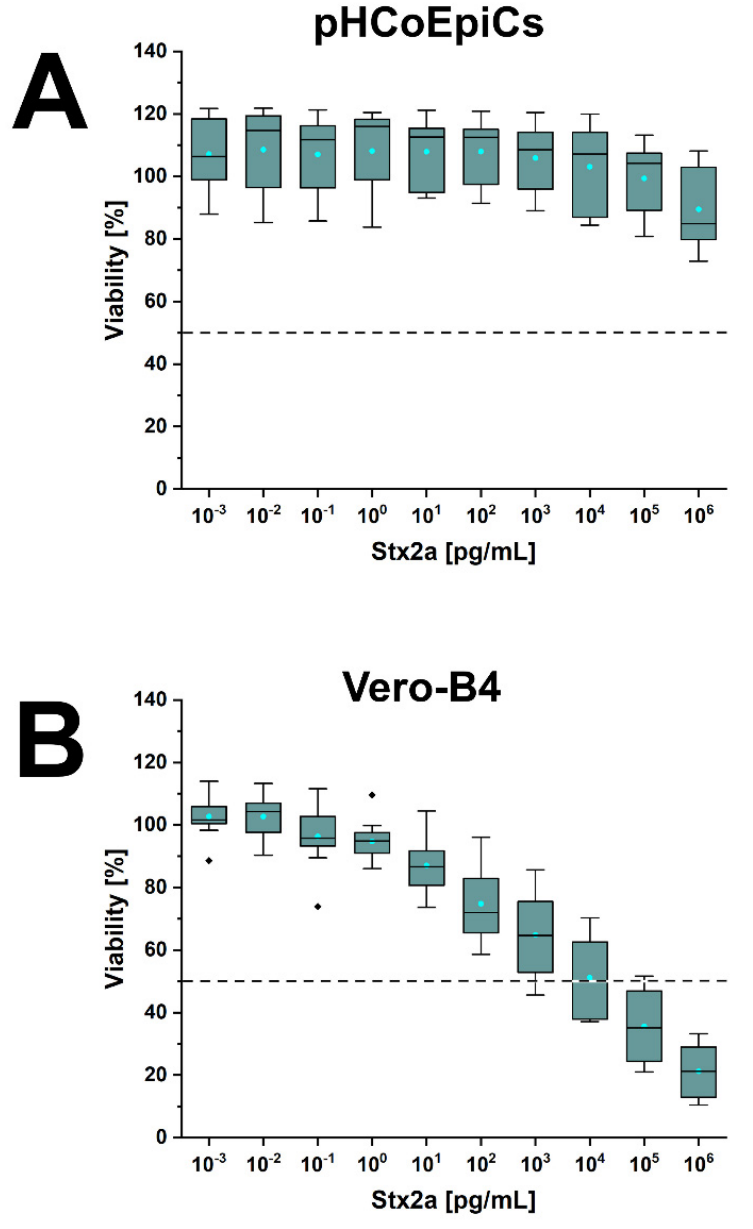
Figure 11. Cytotoxic effect of Stx2a towards pHCoEpiCs ( A ) and Vero-B4 reference cells ( B ). The cell-damaging activity was analyzed with the crystal violet assay, and absorption readouts of Stx2a-challenged cells are presented as box plots. Percentages of cell damage were determined in relation to parallel cell cultures without toxin serving as 100% viability control.